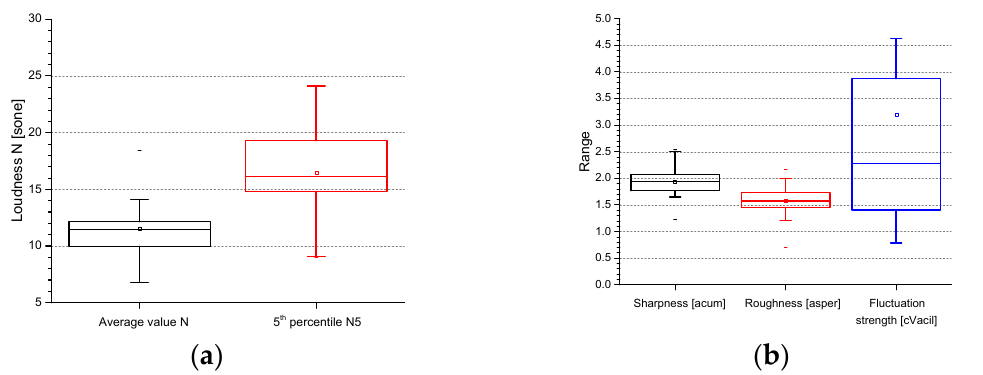
Figure 4. Range of the psychoacoustic metrics observed in the wards: ( a ) average value and 5th percentile of loudness; ( b ) average values of sharpness, roughness, and fluctuation strength. Noise annoyance is a critical factor in increasing stress and reducing work performance.